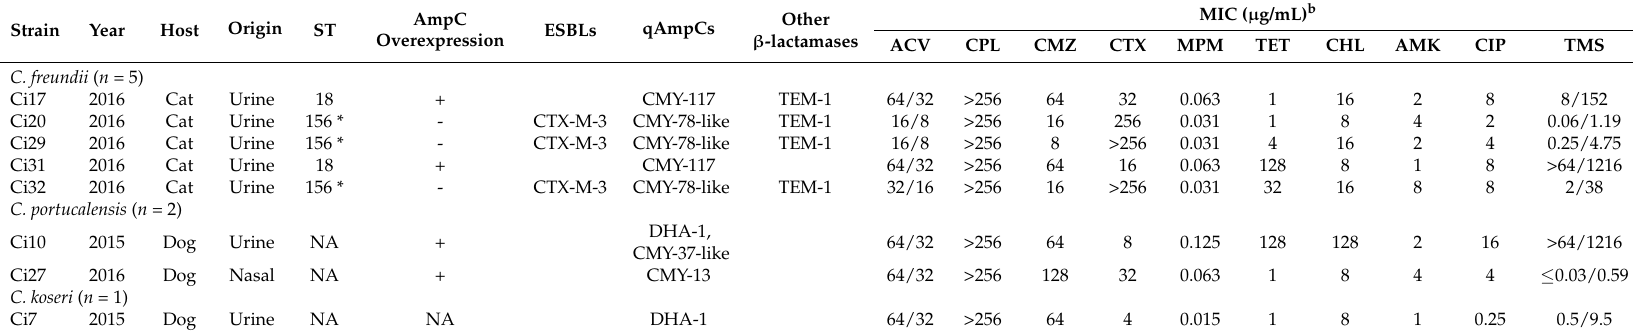
Table 2. Characterization of eight extended-spectrum cephalosporin (ESC)-resistant Citrobacter spp. strains from dogs and